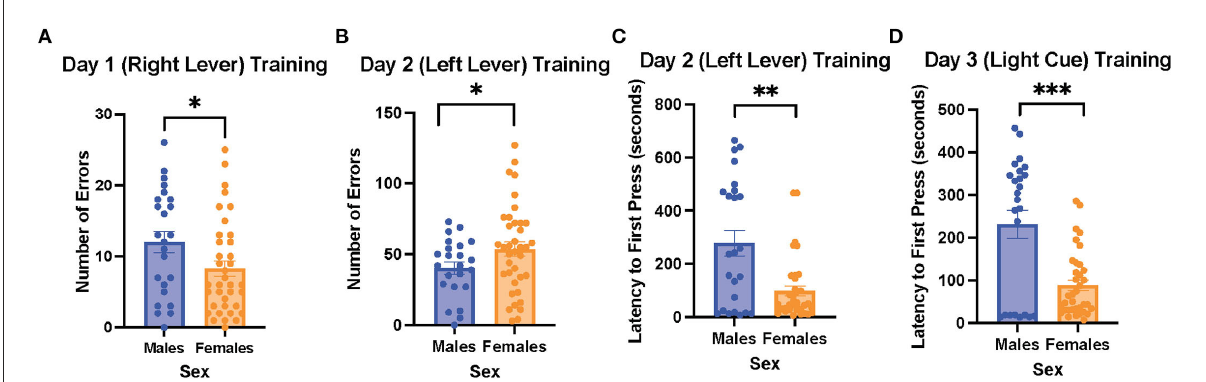
FIGURE2 Female rats made fewer errors than male rats when learning to press the right lever on the 1st day of training, but they made more errors than the male rats when learning to press the left lever on the 2nd day of the training; the female rats also showed a shorter latency to first press than the male rats when learning to press the left lever and respond to the light cue. (A) Number of errors on the 1st day of the training (learning to press the right lever) in the males and female rats. (B) Number of errors on the 2nd day of the training (learning to press the left lever) in the male and female rats. (C) Latency to first press on the 2nd day of the training (learning to press the left lever) in the male and female rats. (D) Latency to first press on the 3rd day of the training (learning to respond to the light cue) in the male and female rats. Independent samples t -tests were conducted to compare the measurements between the mean of males ( n = 24) and the mean of females ( n = 40). Error bars are plotted as mean ± SEM. * p < 0.05, ** p < 0.01, and *** p < 0.001.